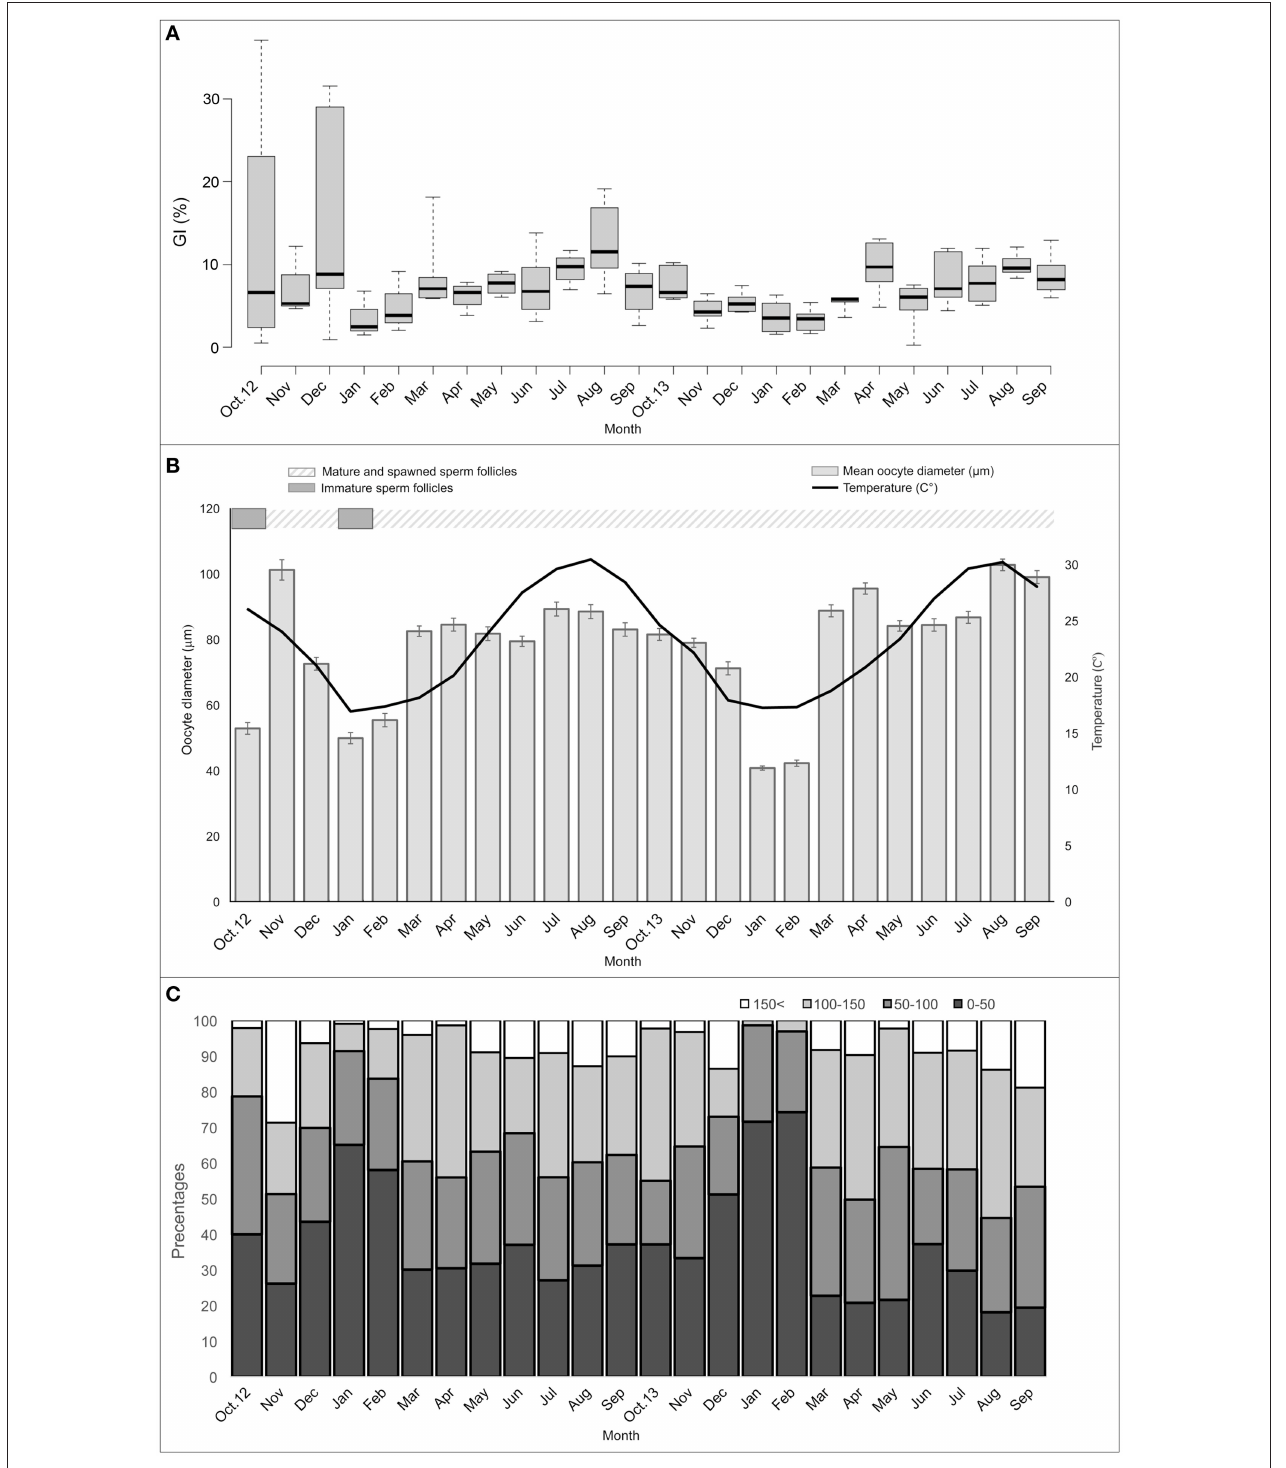
FIGURE 4 | Reproductive cycle of Microcosmus exasperatus. (A) Monthly mean values of Gonad Index (percentages). (B) Mean oocyte diameter and sea surface temperature (1m) as measured at the study site. Male follicle stages are indicated in the bar above. (C) Monthly relative percentages of each oocyte size-class: pre-vitellogenic < 50 µ m; 50–100 µ m; vitellogenic 100–150 µ m; mature > 150 µ m; ( n = 3–9, + SEs).